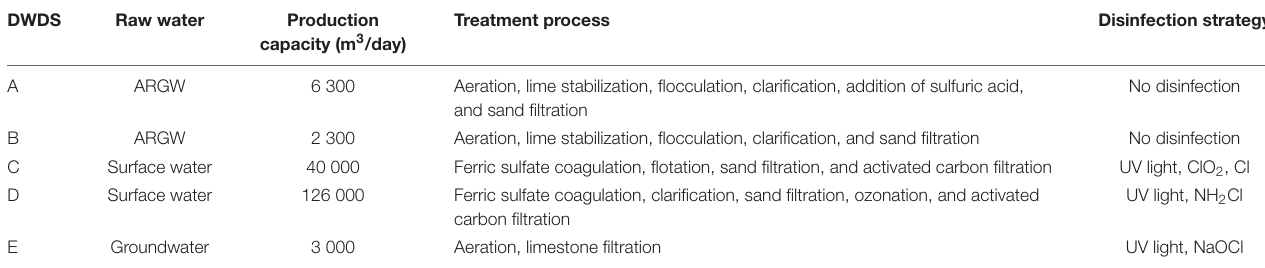
TABLE 1 | Characteristics of drinking water distribution systems (DWDS) included in the study (Ikonen et al., 2017; Inkinen et al., 2019,